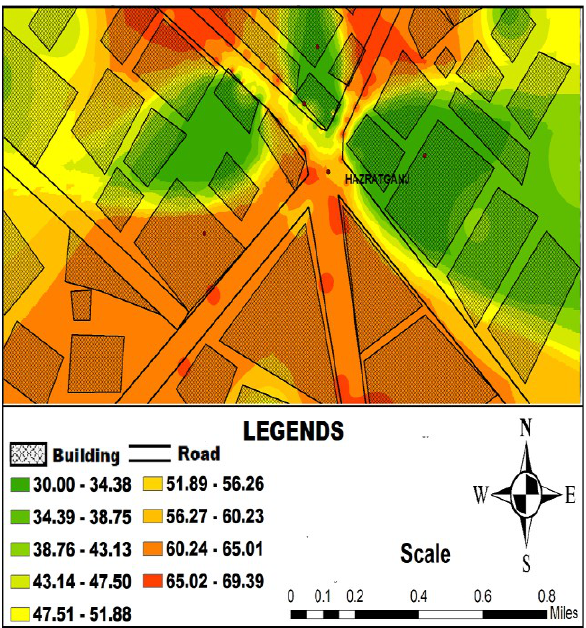
Figure 4. The Noise map of Hazratganj Chauraha of morning slot with value variation is between 30.00 to 69.39. Barrier and distance attenuation is also calculated and mapped.